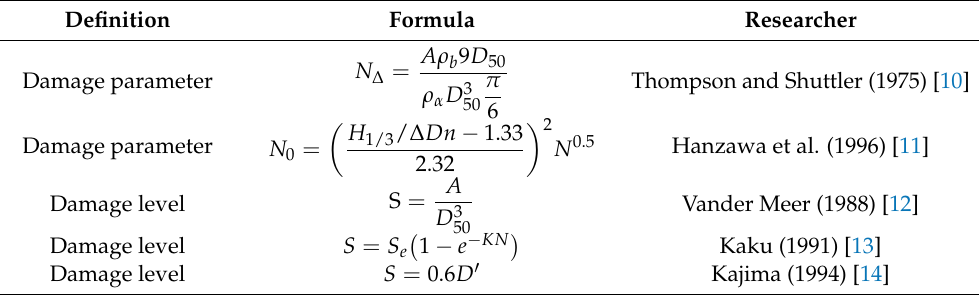
Table 1. Various definitions for the damage parameter (damage